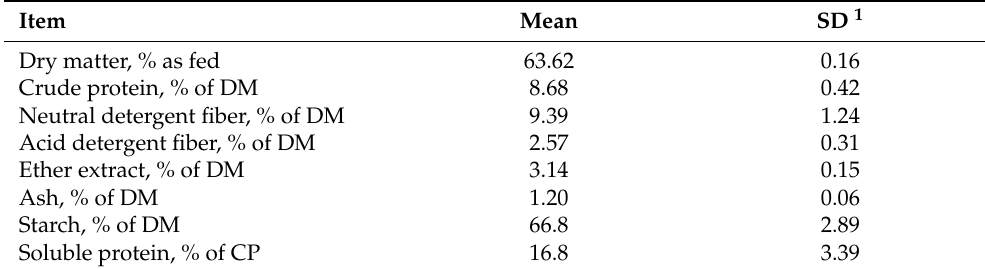
Table 1. Dry matter content and chemical composition of fresh reconstituted corn grain (n =